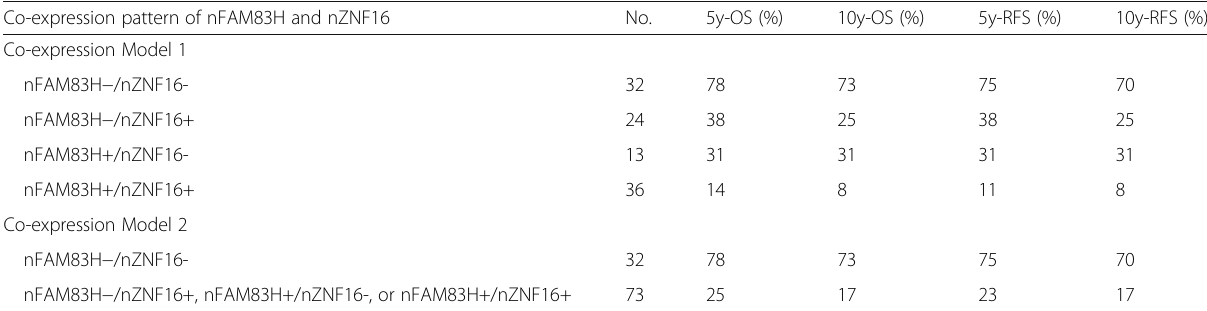
Table 4 Five- and ten-year overall survival and relapse-free survival according to co-expression patterns of nuclear FAM83H and nuclear ZNF16 Co-expression pattern of nFAM83H and nZNF16